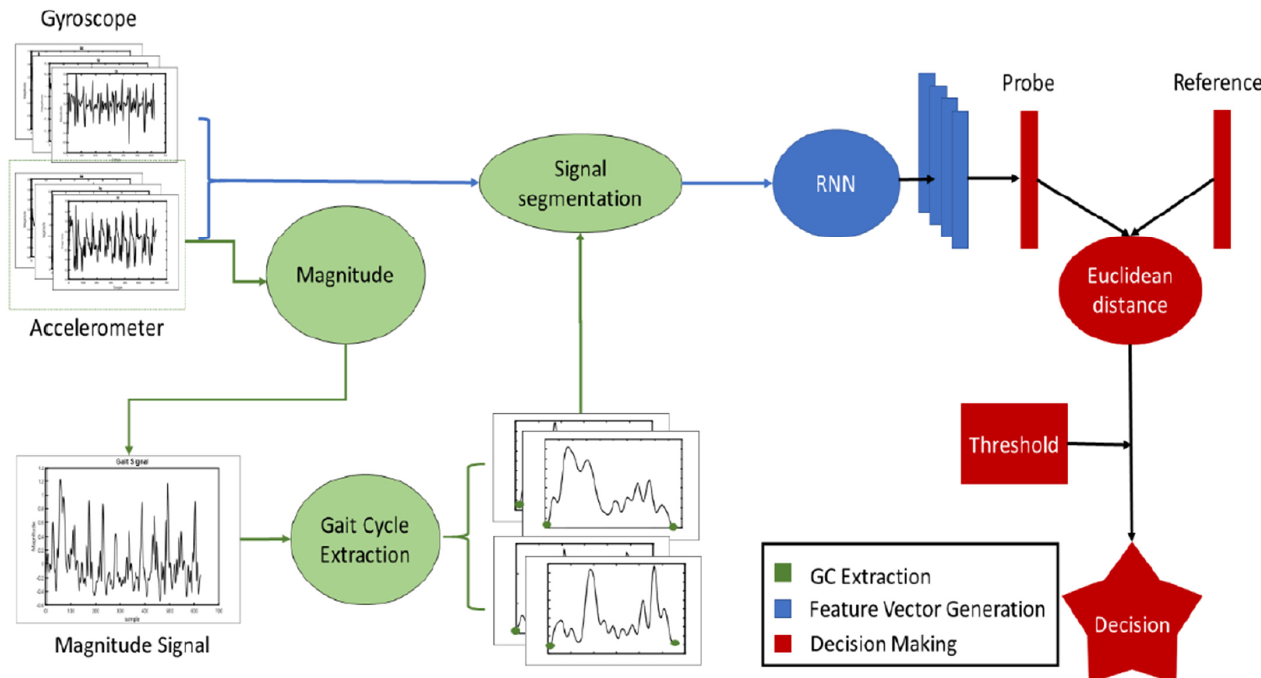
Figure 1. Proposed model for inertial gate authentication [19].